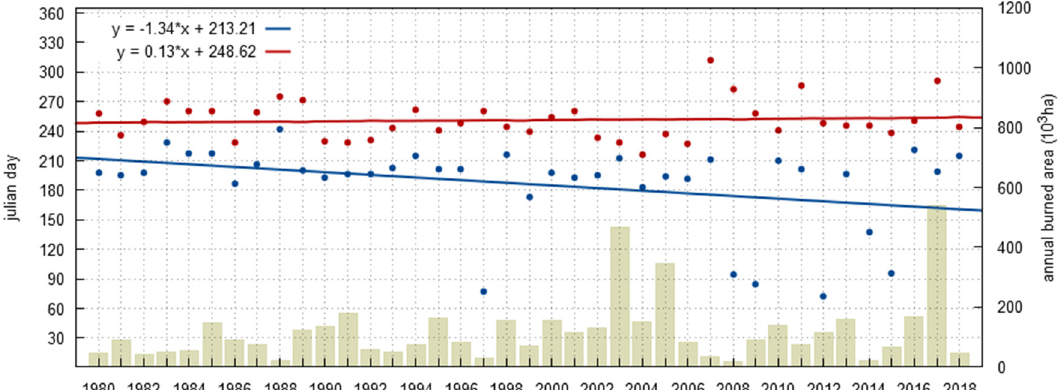
Figure 6. Evolution of the dates on which the 15% (blue points) and 85% (red points) fractions of the total annual burned area were exceeded in the period of 1980–2018, and corresponding adjusted linear regressions. Gray bars show the annual burned area.